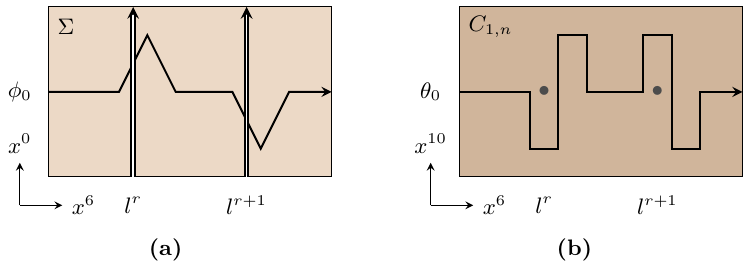
Figure 3 . (a) A path in Σ bending near double lines. (b) The corresponding path in C 1 ,n detours around the